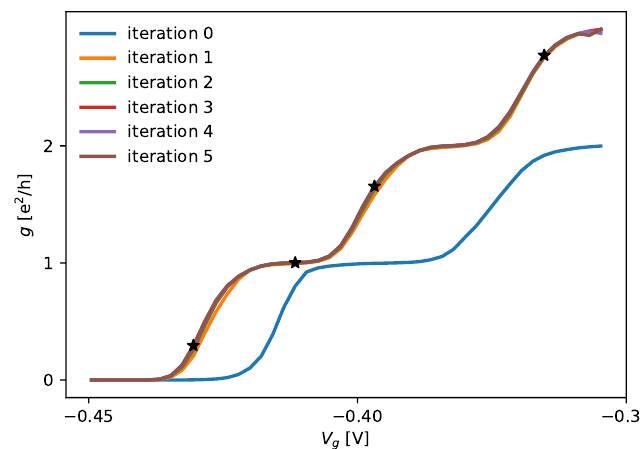
Figure 15: Conductance of a QPC in units of e 2 / h as a function of the gate voltage V for different quantum iterations (QAA). The zeroth iteration (blue line) corre- g sponds to Thomas Fermi calculations. The black star indicates the chosen voltages and conductances for Fig